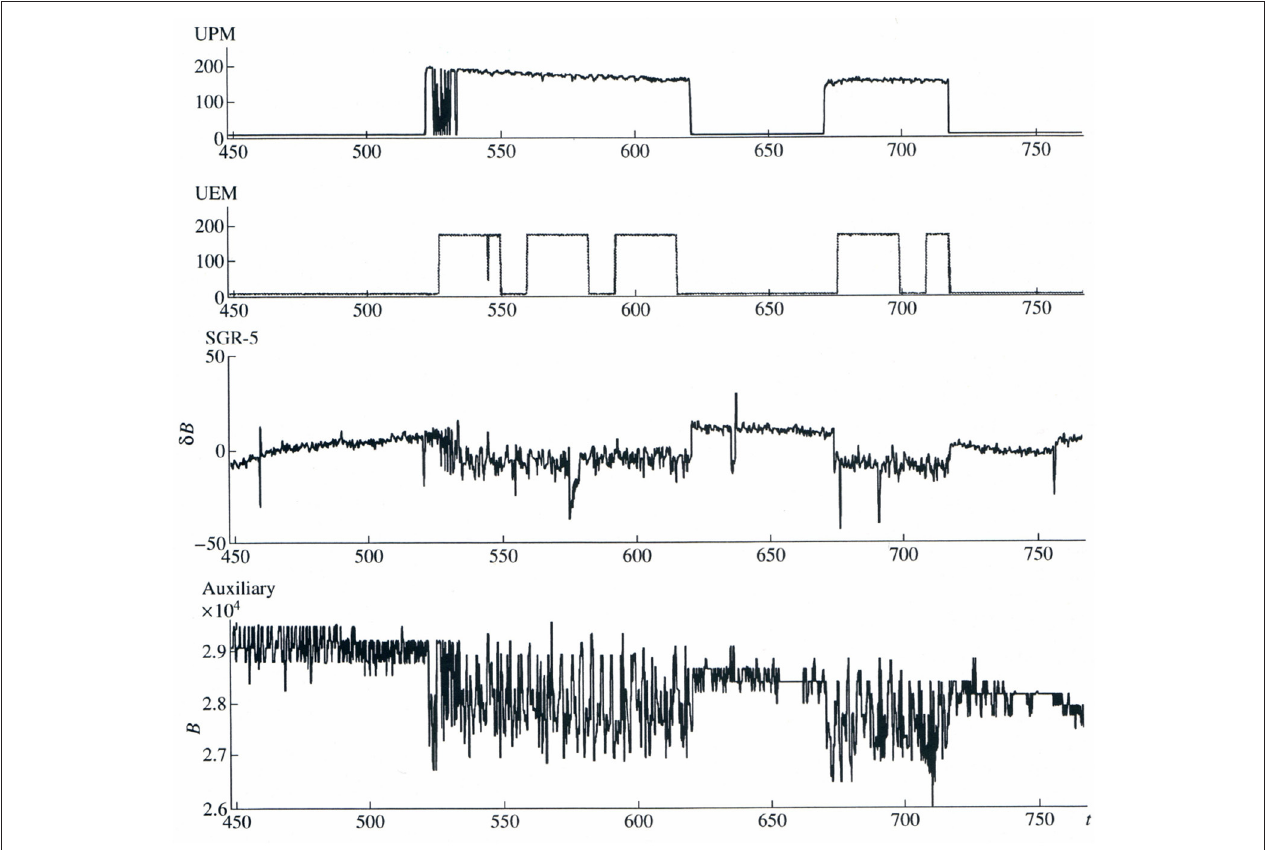
FIGURE 9 | Illustration of the diamagnetic cavity formation as seen in the time-dependent variations of the magnetic field. Horizontal axis—the time [s] lapsed from 04:37:02 UT, obtained during the xenon plasma injection on March 13, 1992 (orbit 1019). From top to bottom the UPM and UEM acceleration voltage [a.u.], deviation of the magnetic field strength [nT] from a mean level (SGR–5), and the service magnetometer total magnetic field [nT]. (Reprinted from Volokitin et al.,